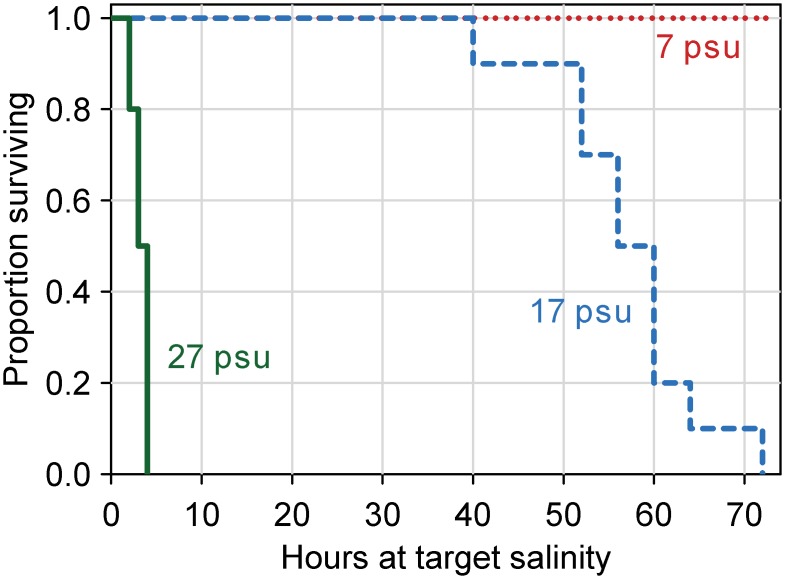
Survival of blue catfish over time after gradual transfer from freshwater to one of three salinity treatments during the pilot experiment.Figure available in color online.